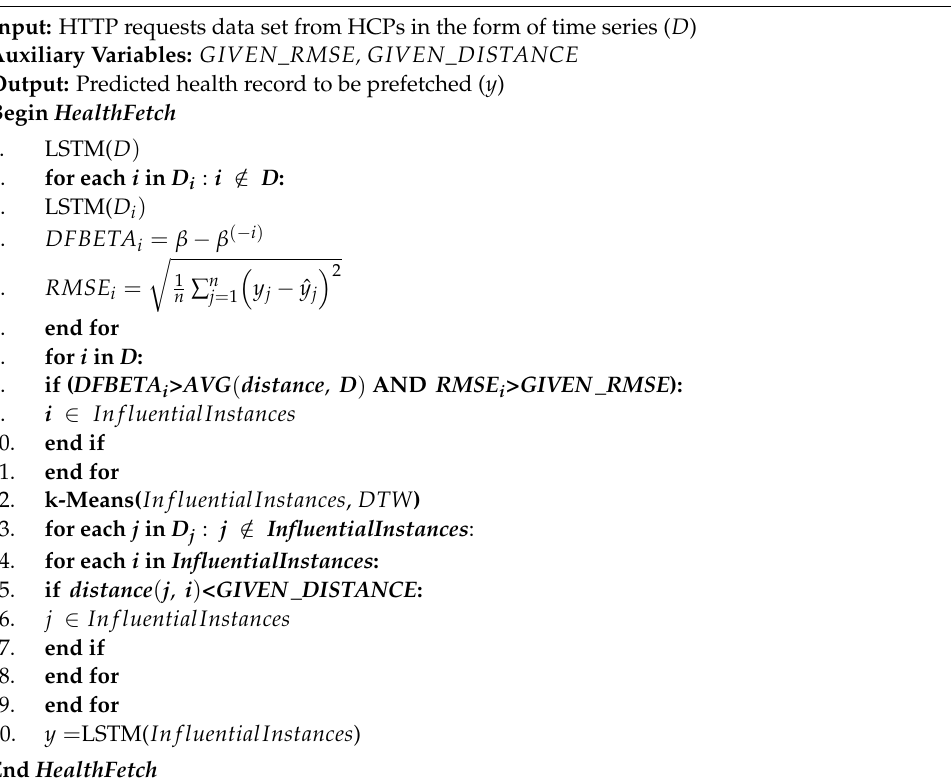
Algorithm 1 Prefetch scheme